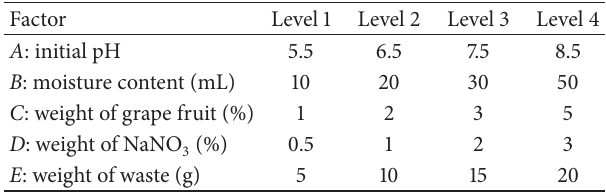
Table 3: Factors and their levels which were studied by Taguchi